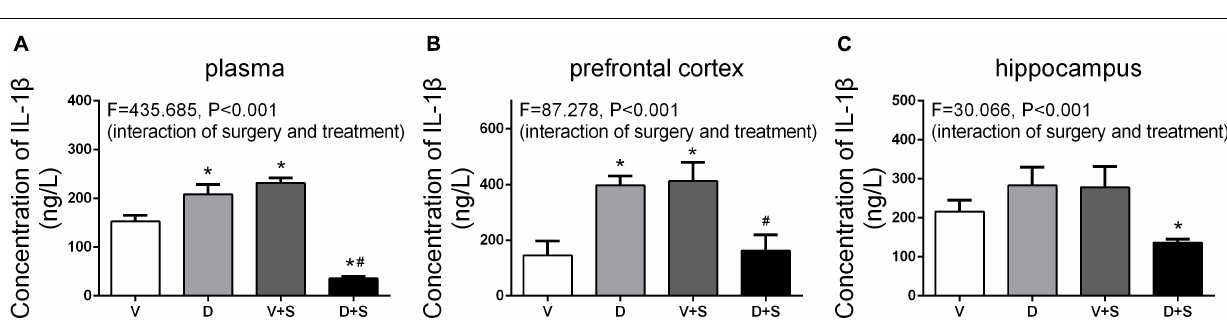
FIGURE 7 | DSP-4 treatment inhibits the increase in interleukin-1 β (IL-1 β ) levels caused by surgery at 1 week postoperatively. Prior to the central administration of DSP-4 attenuated the surgery-induced increase in IL-1 β levels in the plasma (A) , prefrontal cortex (B) , and hippocampus (C) . The data are presented as the means ± SEM for each group ( n = 4 per cohort). * p < 0.05 compared to Group V, # p < 0.05 compared to Group V + S, DP < 0.05 compared to Group